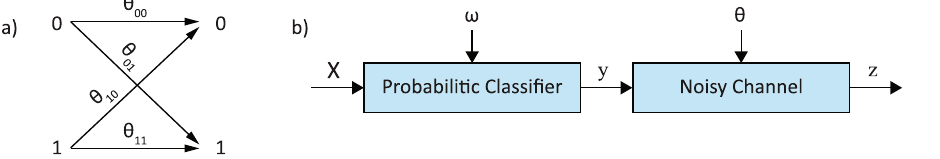
Figure 3. A schemes of the probabilistic model. (a) A diagram of the connections between the true label (left) and the observed label (right). (b) A diagram of logistic regression with noisy labels.